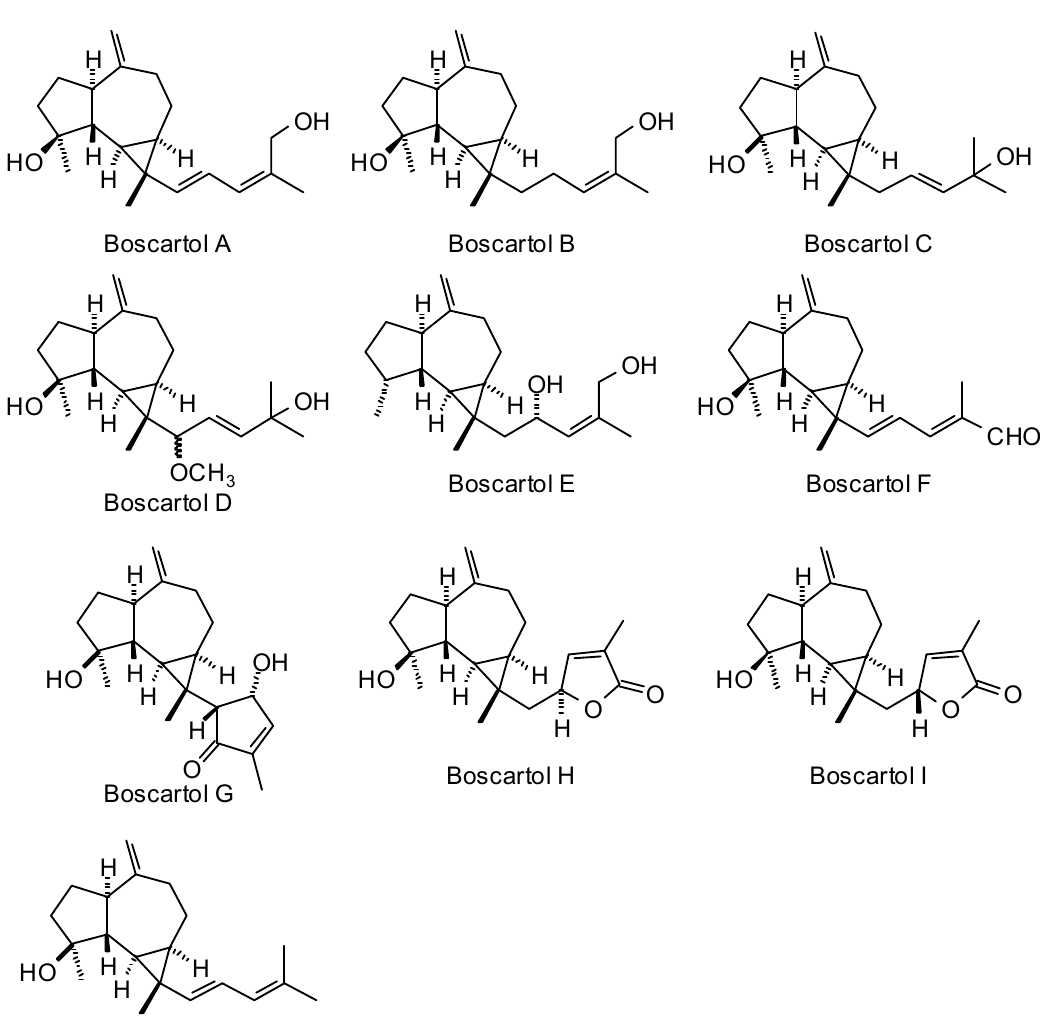
Figure 2. Cneorubenoid diterpenoids isolated from Boswellia carteri .